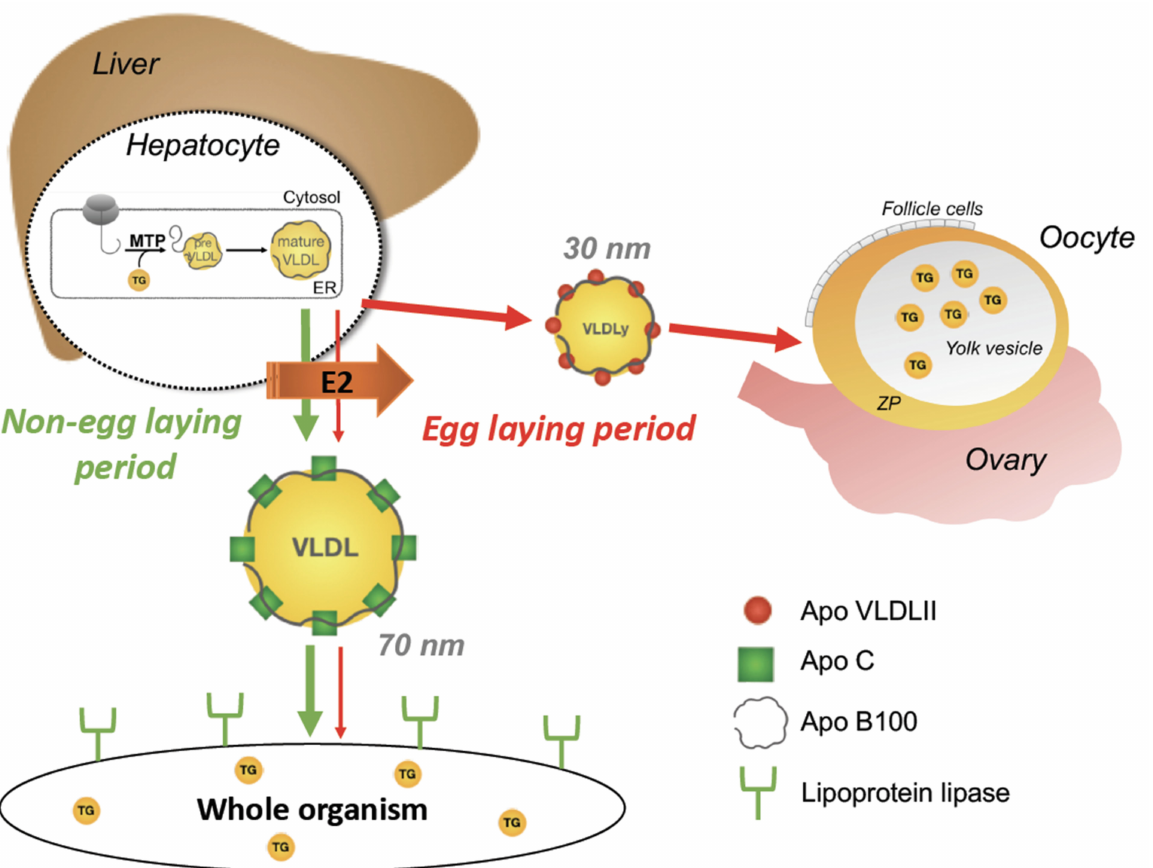
Figure 4. Role of estrogens in lipoprotein metabolism in oviparous vertebrates. VLDL particles (70 nm) produced in the liver provide TGs to the whole body (green arrows). During the egg-laying period, there is a shift induced by E2 to produce lipoprotein lipase-resistant yolk targeted VLDLy particles (30 nm) delivering TGs to the growing oocytes (thick red arrows), which reduces the levels of the 70 nm particles (thin red arrows) during this period. See text for additional information. E2: 17 β -estradiol; TG: triglyceride; VLDL: very low density lipoprotein; VLDLy: yolk targeted VLDL; MTP: microsomal triglyceride transfer